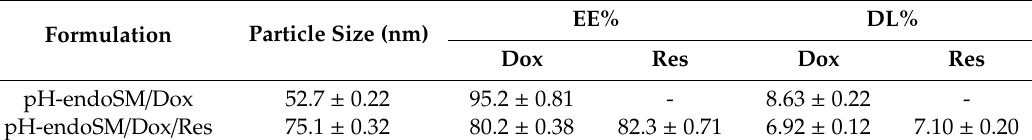
Table 1. The physicochemical characterization results of the micelles.